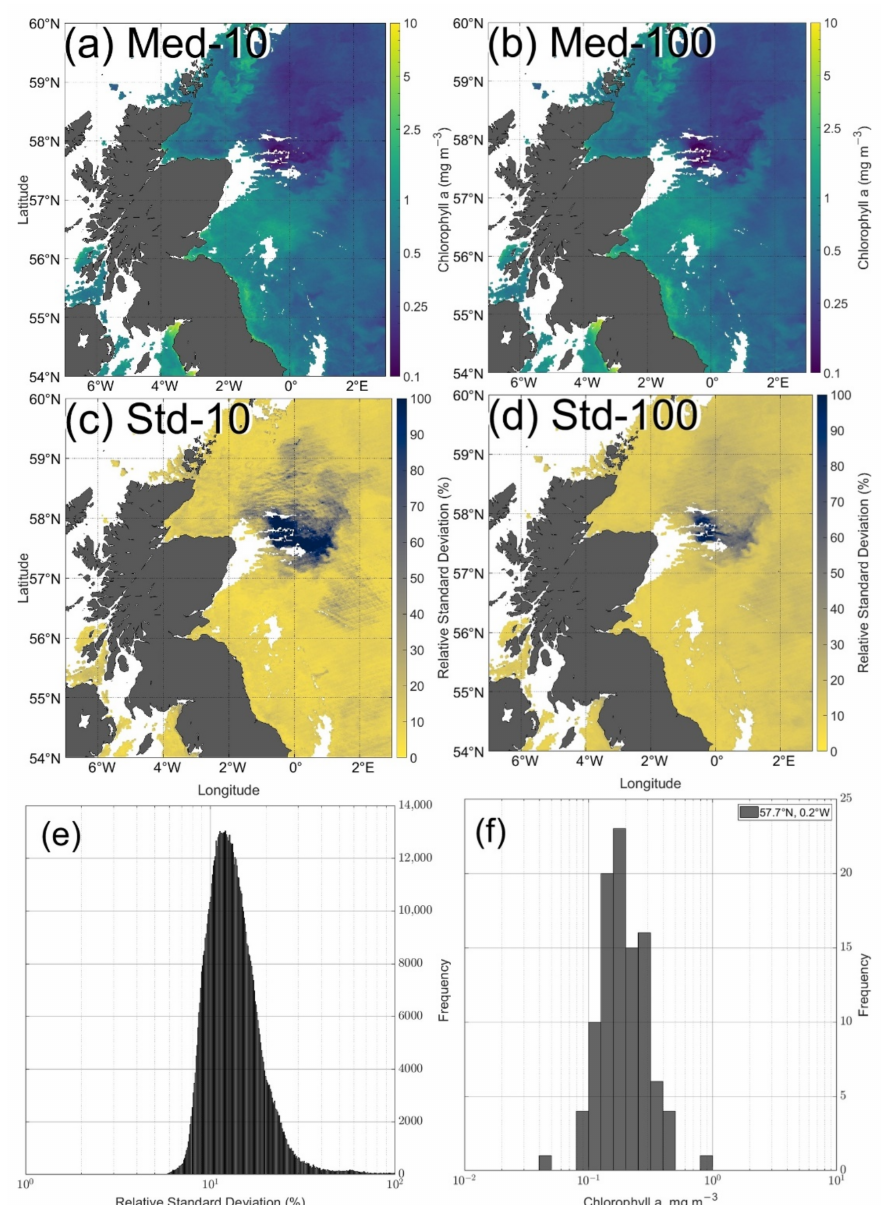
Figure 7. Chlorophyll prediction from the neural networks using ( a ) 10 networks and ( b ) 100 networks averaged (median). Relative standard deviation (relative to the median) for the same image expressed in percentage using ( c ) the same 10 or ( d ) 100 networks. ( e ) Histogram of the relative standard deviation of the panel ( d ) using 100 networks expressed in percentage. ( f ) Histogram of a random point inside the coccolithophore